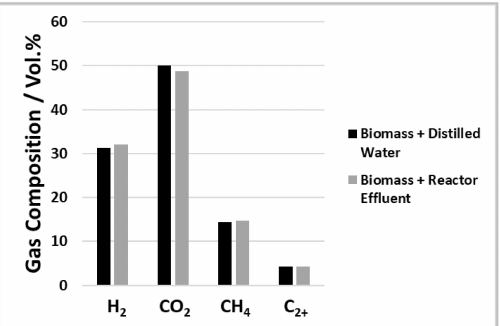
Figure 7. Gas composition of gasification experiments with grapevines for two different